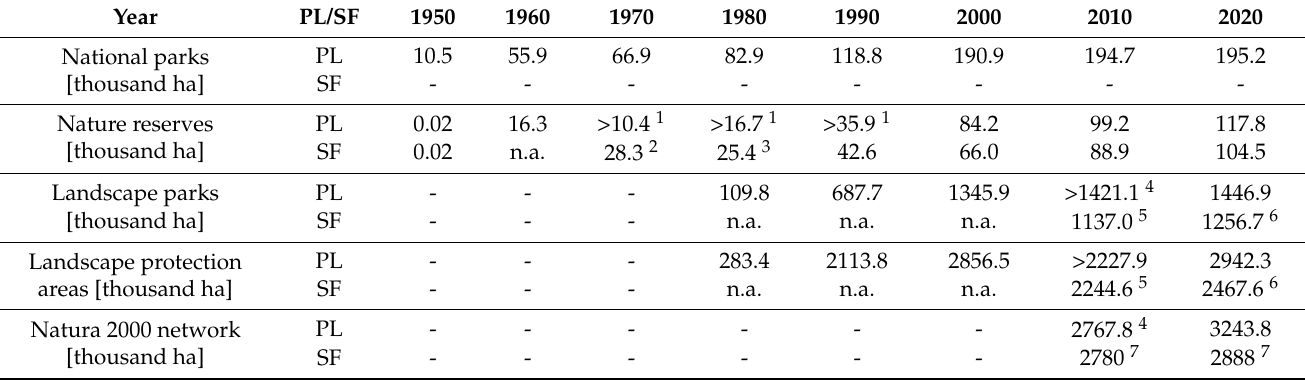
Table 3. Area of protected forests (PL—Poland, SF—State Forests)